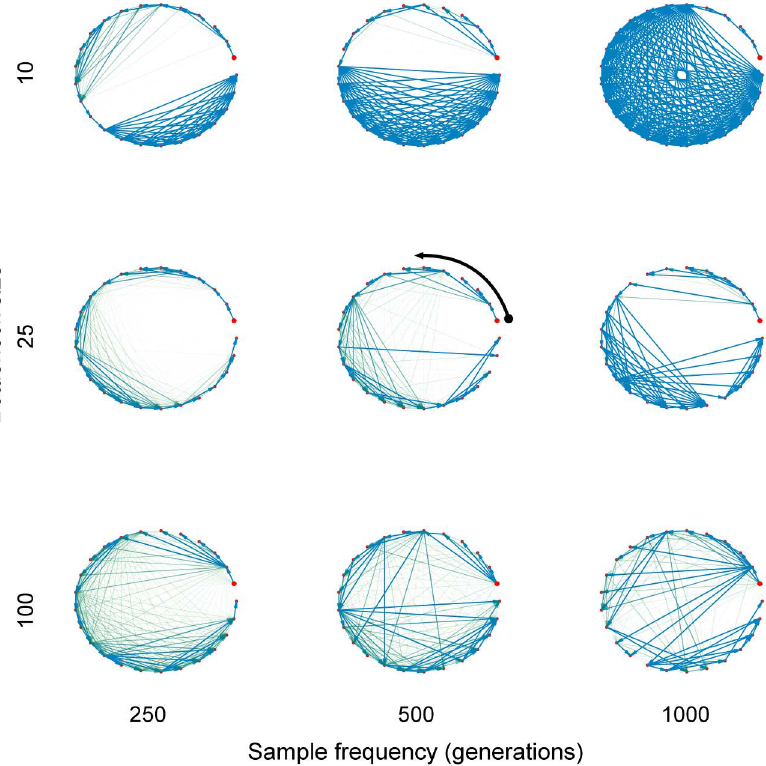
Figure 2. Estimated transmission networks, based on periodical sampling of isolates. The true transmission chain begins with individual identified by the large red dot, and proceeds around the circle as directed by the black arrow. The first individual had a heterogeneous infection, with an expected pairwise distance of 5 SNPs. Each network represents a single estimate of a simulation, with edge weighting proportional to the relative probability of infectious contact, inversely proportional to the mean genetic distance between individuals. It was assumed that the order of infection is known, such that the k th infection has k { 1 potential sources.